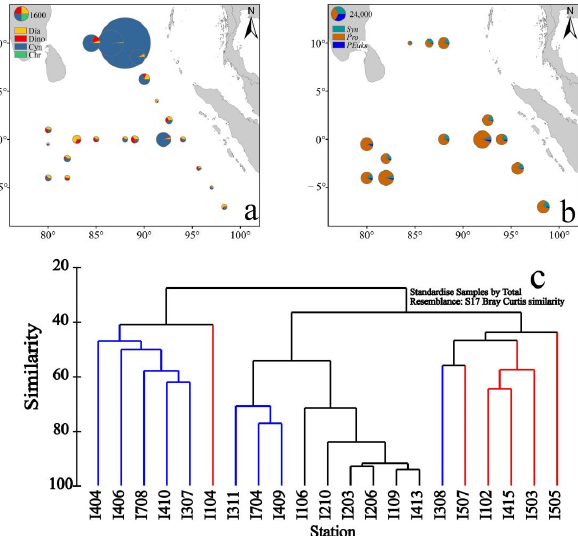
Figure 3. Horizontal distribution and cluster analysis of phytoplankton. ( a ) Horizontal distribution of Microphytoplankton (cells/L) (Diatoms: Dia; Dinoflagellate: Dino; Cyanobacteria: Cyn; Chryso ‐ phyta: Chr), ( b ) Horizontal distribution of Picophytoplankton (cells/mL) (weighted average) ( Syn ‐ echococcus: Syn; Prochlorococcus: Pro; Picoeukaryotes: PEuks ), ( c ) Cluster analysis of phytoplankton community structure (weighted average). The blue line indicates the station name of EQ, the red line indicates the stations of EB, and the black line indicates the station name of BOB. The vertical distributions of phytoplankton were different in these three regions. The microphytoplankton in the three regions are mainly composed of diatoms, dinoflagel ‐ lates, and Trichodesmium sp. The diatoms in the three regions increased in the upper 75 m and then gradually decreased with depth. Dinoflagellates decreased from the surface to the bottom. Cyanobacteria are mainly distributed in the upper layer. The abundance of Trichodesmium sp. in the BOB was higher than in the other two regions. The vertical dis ‐ tributions of picophytoplankton were similar in the three regions, while the abundance of picophytoplankton was the lowest in the BOB (Figure 4a–c). For Syn , the maximum abun ‐ dance was observed in the surface layer (3–50 m) and then gradually decreased with in ‐ creasing depth. In contrast, the abundance of Pro reached the maximum at depths of 50– 75 m and then rapidly dropped to a minimum in the bottom layer (150–200 m). PEuks had similar vertical distributions with Pro but was 1–2 orders of magnitude lower than Pro (Figure 4d–f). Comparing the Shannon–Wiener diversity index ( H’ ) of the three regions, the Shannon–Wiener diversity index (H’ ) of BOB is the lowest at the upper layers, and the Shannon–Wiener diversity index ( H’ ) of EB and EQ are at the bottom layers (Figure 4g–i). The trend of the Pielou index (J ) is similar to that of the Shannon–Wiener diversity index (Figure 4g–i).